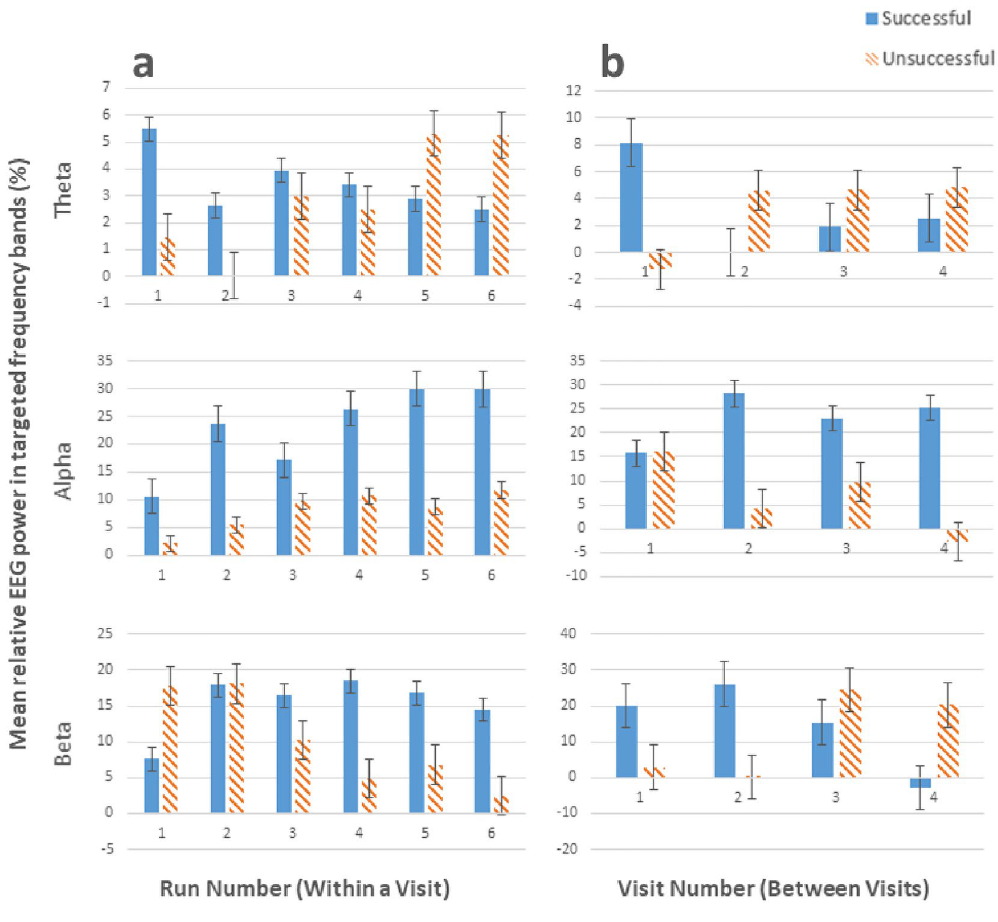
Figure 3. Comparisons of successful and unsuccessful performances ( a ) within a visit (i.e. between runs) and ( b ) between visits for each frequency band (theta, alpha, and beta).